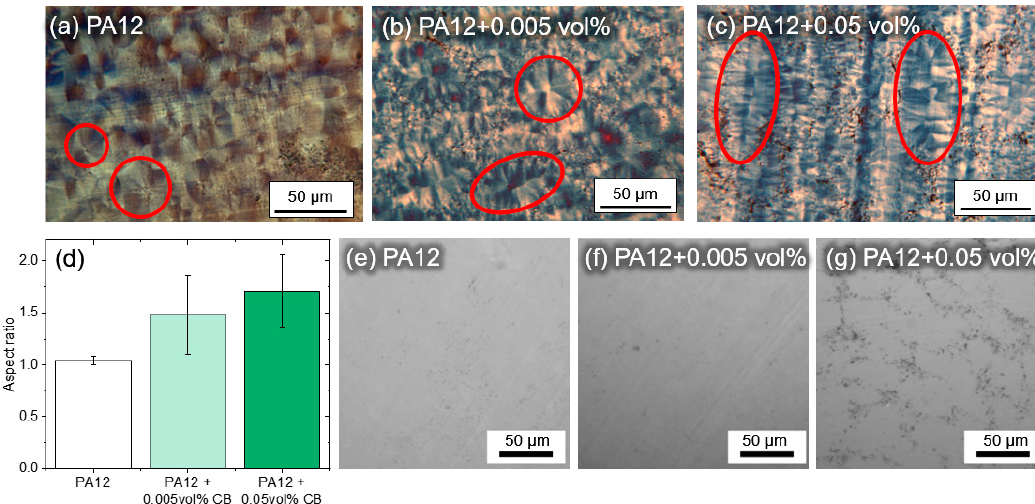
Figure 11. ( a – c ) Polarization microscopy images of PA12 with different carbon nanoparticles loading, showing representative crystalline structures of different dimensions. ( d ) Corresponding aspect ratio of observed crystalline shapes at different carbon nanoparticles loadings. ( e – g ) Bright-field images of PA12 with carbon nanoparticles, depicted as black dots. Samples were analyzed after sizing to 10 µm films.